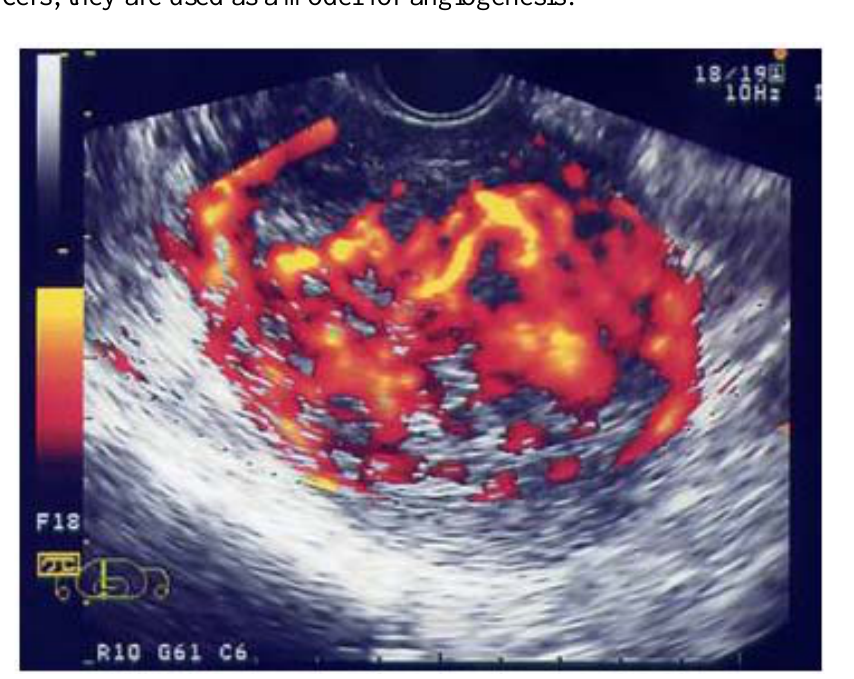
Figure 2. Potential blood flow (angiogenesis) of malignant tumors is enhanced and extracted using color Doppler ultrasound imaging. This picture is a clinical case of uterine sarcoma, using Levovist. Because uterine sarcomas have the most aggressive angiogenesis among all uterine cancers, they are used as a model for